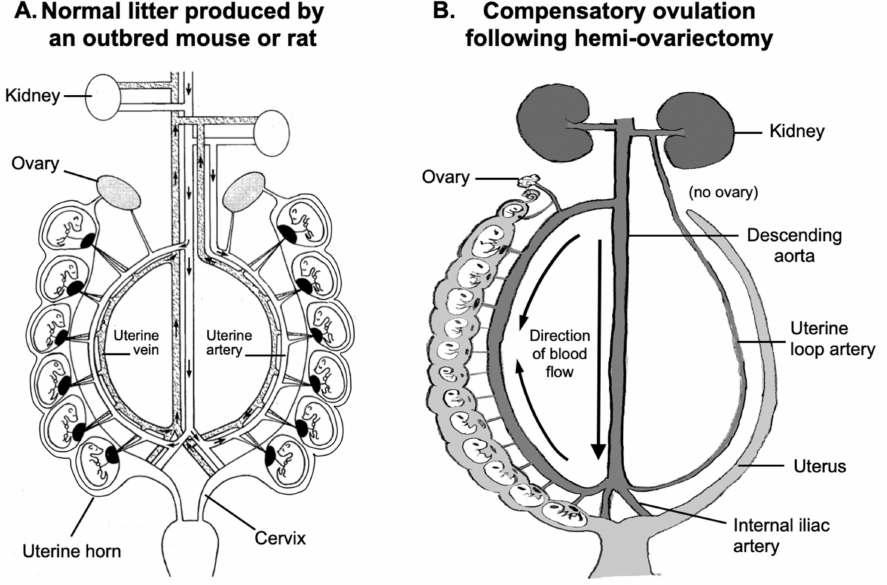
Figure 1. The pregnant mouse uterus. ( A ) The intact duplex uterus of the mouse or rat, with each uterine horn having an independent cervix. The bi-direction blood flow in each uterine artery and vein is indicated by arrows. Modified from Even et al. [21], with permission. The left kidney is caudal to the right kidney, which leads to variability in the cranial vascular anatomy of the left uterine horn. ( B ) The consequence of hemi-ovariectomy on ovulation in litter-bearing species that normally ovulate from both ovaries, which is referred to as compensatory ovarian hypertrophy due to the remaining ovary ovulating the normal number of oocytes that would have been produced by both ovaries. Due to the variability in the vascular anatomy of the left uterine horn, all mice had the left ovary removed, which resulted in compensatory ovulation by the remaining right ovary and crowding of fetuses in the right uterine horn. Fetuses that end up randomly implanted in the middle portion of the uterus [24] have reduced blood flow and nutrient transport across the placenta relative to siblings at the ends of the horn, due to the bi-directional uterine arterial blood flow; however, if the fetus at the cranial end of the crowded uterus has a placental artery that branches off of the ovarian artery (as shown in Panel B ), this fetus will be IUGR rather than macrosomic [19,22]. Modified from Coe et al. [22], with